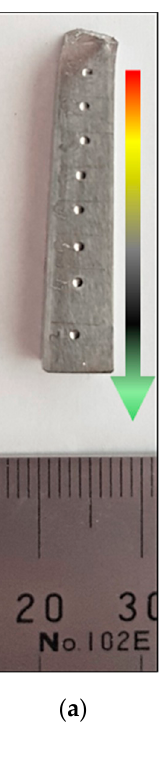
Figure 11. LCF tested specimen: ( a ) gage part of the specimen after indentation tests; ( b ) and indentation force–displacement plots.